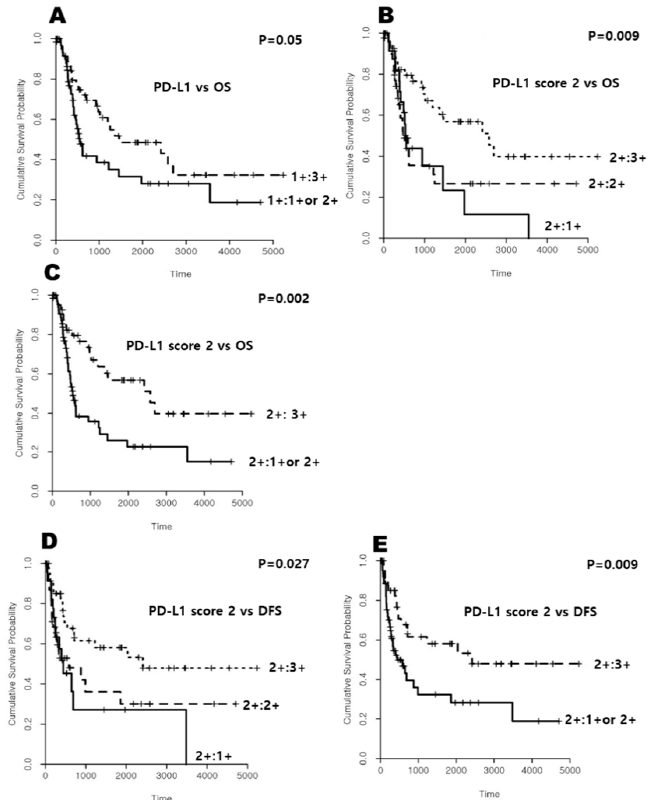
Figure 1. Kaplan-Meier plots on the relationship between immune cell markers and overall survival (OS) and disease-free survival (DFS) in the periampullary/pancreatic cancers patients. There was a significant difference between PD-L1 and OS according to ( A ) PD-L1 (1+:3+ vs. 1+:1+ or 2+), ( B ) PD-L1 (2+:3+ vs. 2+:2+ vs. 2+:1+), and ( C ) PD-L1 (2+:3+ vs. 2+:1+ or 2+), while there was also a significant relationship between PD-L1 and DFS according to ( D ) PD-L1 (2+:3+ vs. 2+:2+ vs. 2+:1+), and ( E ) PD-L1 (2+:3+ vs. 2+:1+ or